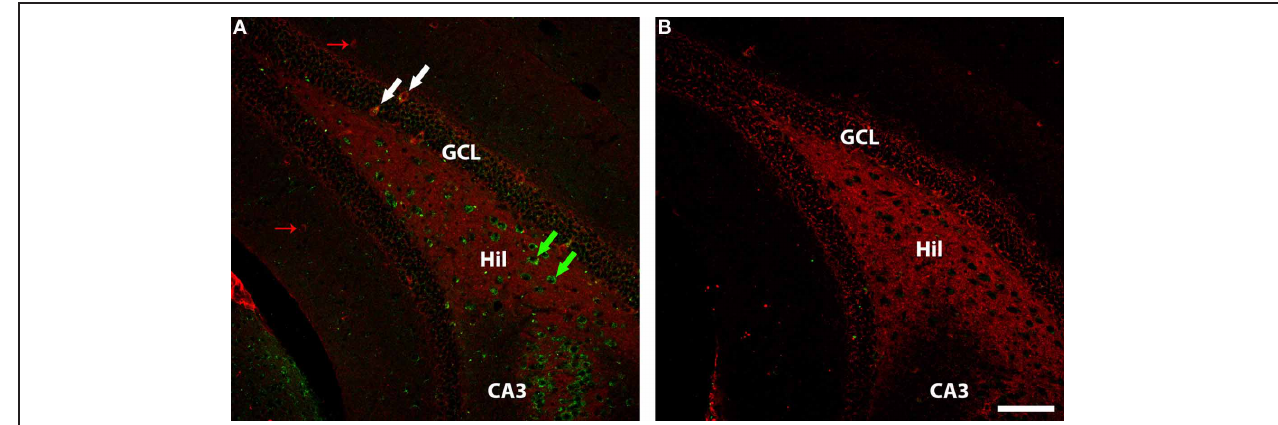
arrows). GAD-67 + only interneurons are seen in the molecular layer (small red arrows). WGA + hilar interneurons void of GAD67 staining are putative glutamatergic mossy cells. Scale is 100 μ m.